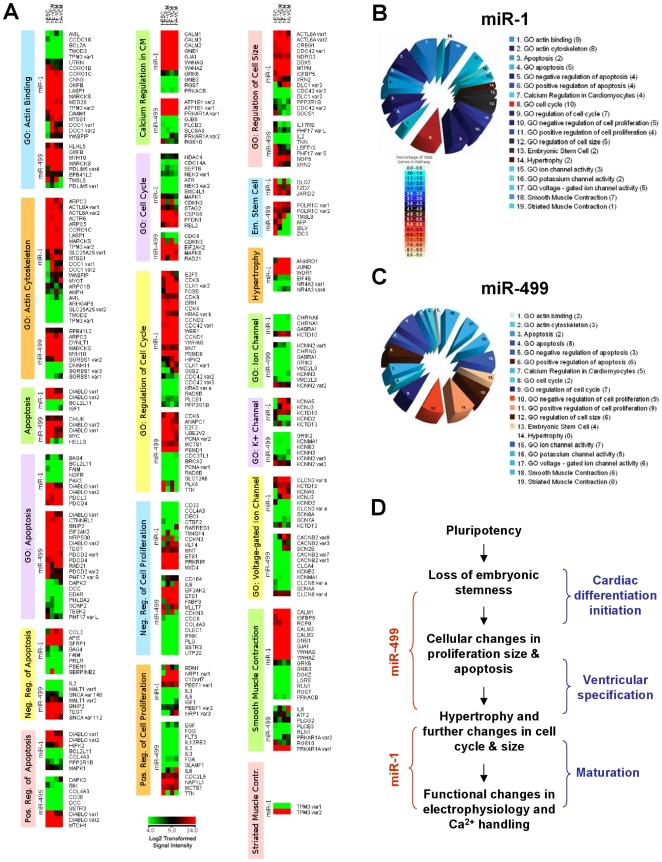
Analysis of Putative Transcriptomic Effects of miR-1 and -499 Expression in CM Development and Maturation.A) Transcriptomic analysis of predicted targets for miR-1 and -499 involved in select pathways as indicated. All genes were log2 transformed and normalized. Cluster analysis was performed with Cluster 3.0 using centroid linkage. Pie charts for B) miR-1 and C) -499 summarizing the number of genes (in parentheses) in each selected pathway or Gene Ontology (GO) classification that were found to agree with our transcriptomic data. See text for further details. The color gradient corresponds to a percentage (% = number of genes in each group meeting criteria/total number of genes in pathway or GO classification * 100). D) Summary of the proposed sequence of biological processes that occur during human cardiogenesis and the actions of miR-1 and -499.